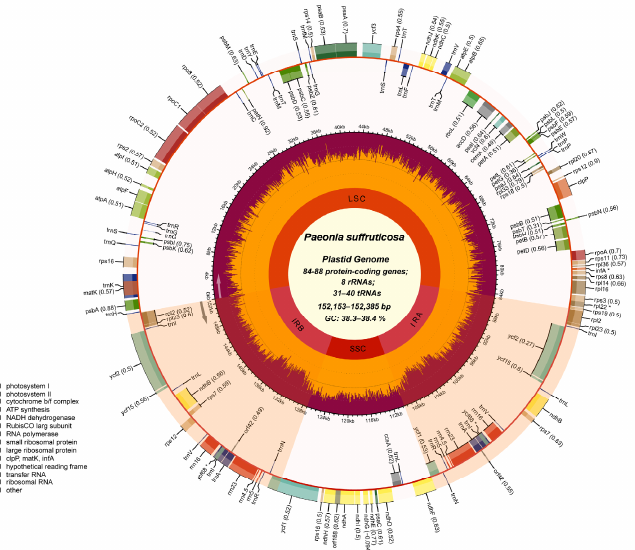
Figure 2. Chloroplast genome map of 10 tree peony flower types using P. suffruticosa cv. ‘Da Zong Zi’ as the template. The gradient GC content of the genome was plotted in the second circle, with a